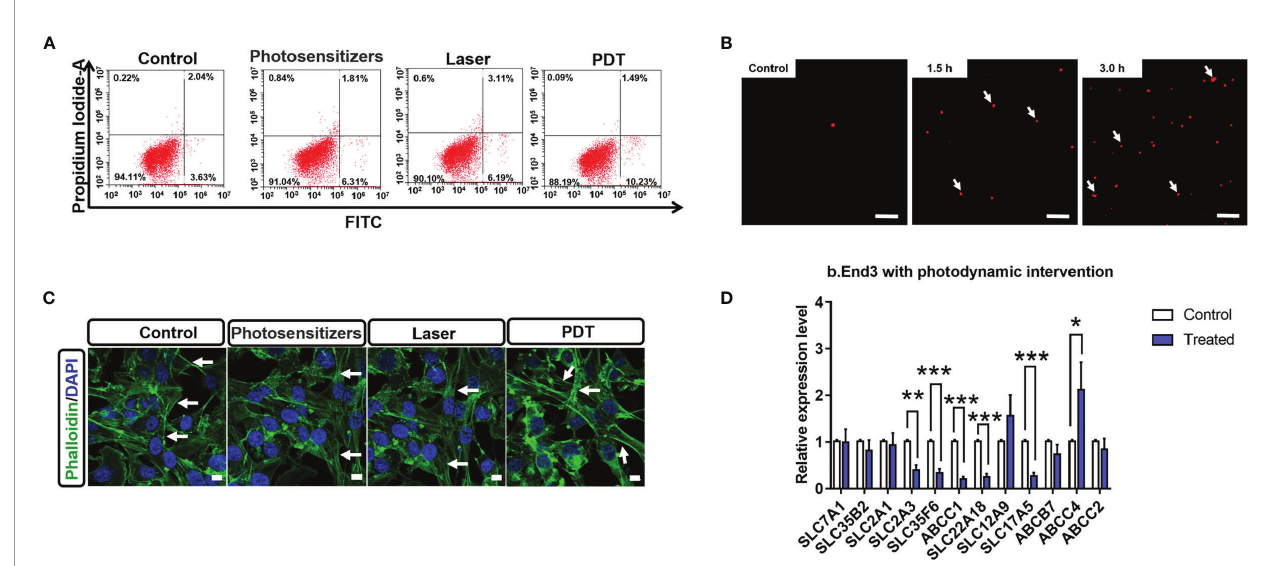
FIGURE 1 | (A) Percentage of apoptotic cells stained by Annexin V-FITC and propidium iodide after PDT intervention at 24 h (B) Comet assays of B.END3 cells with PDT intervention at 1.5 h and 3.0 h compared to the control group. Nucleus is stained by ethidium bromide. The scale bar is 100 m m. (C) Immunostaining for cellular skeletons on control, photosensitizer-treated group, only laser-treated group, and PDT-treated group. Nucleus is stained by DAPI. The scale bar is 50 m m. (D) Quanti fi cation for mRNA levels of BBB critical biomarkers in B.End3 cells after photodynamic intervention (dose 20 J/cm 2 ) (n = 3/group). *p<0.05; **p<0.01;